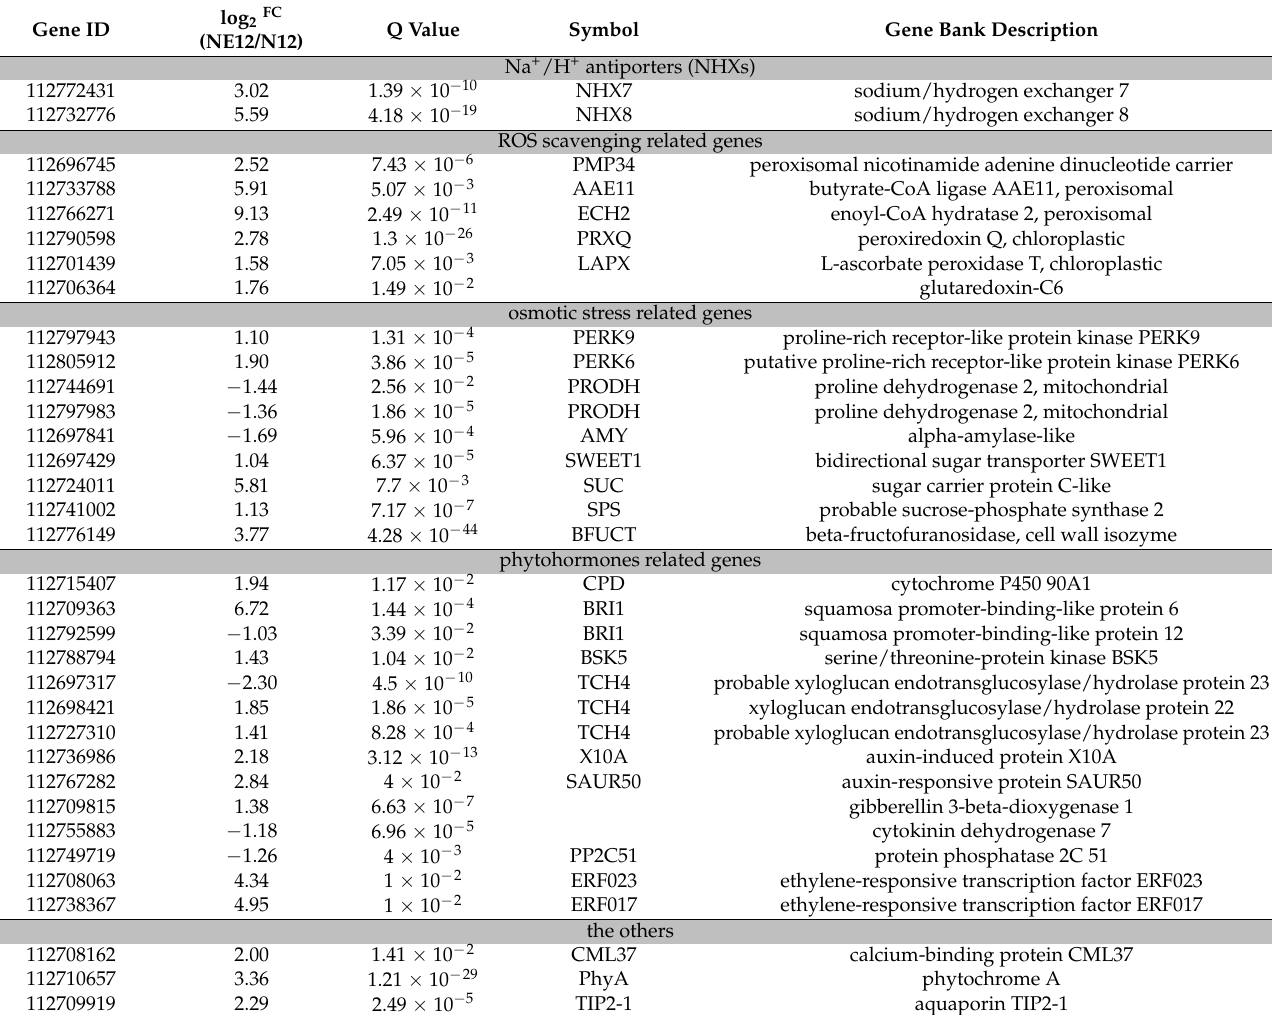
Table 2. Expressed changes of salt tolerance